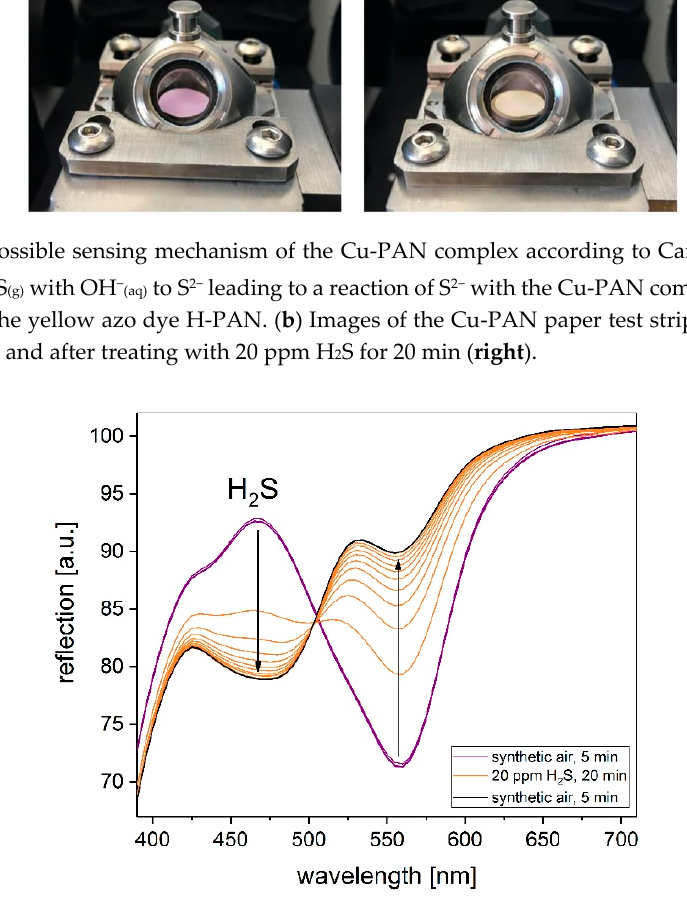
Figure 2. Reflection spectra of Cu-PAN layers on coated paper exposed to 20 ppm H 2 S in synthetic air and a relative humidity of 40% at room temperature. Recording of 15 measurement cycles with a time lag of two minutes,